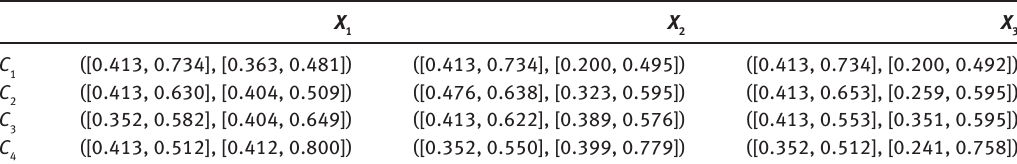
Table 11: Collective Pythagorean Fuzzy Ordered Decision Matrix R